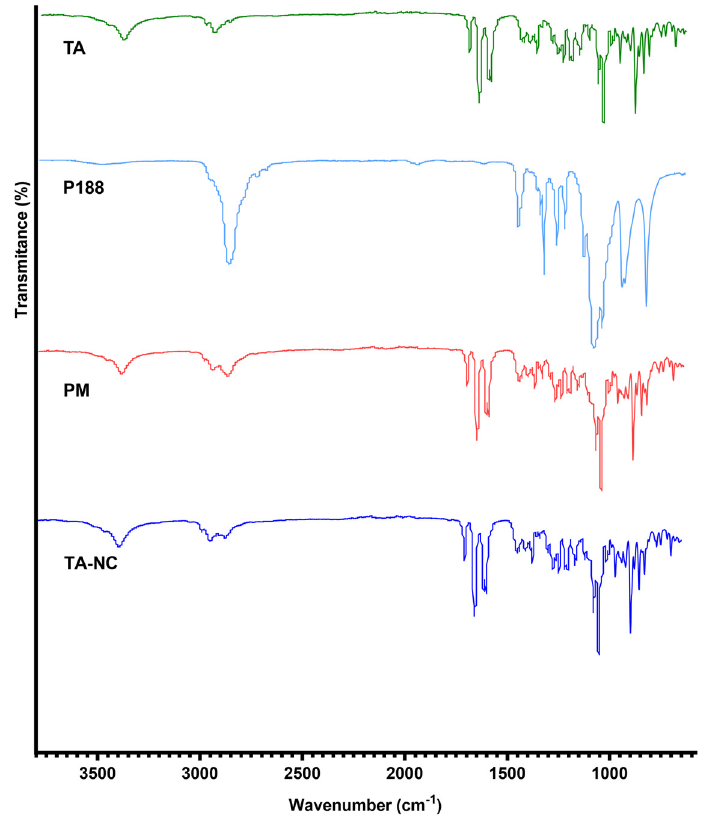
Figure 5. Fourier-transformed infrared (FTIR) spectrometry of mTA, P188, PM and